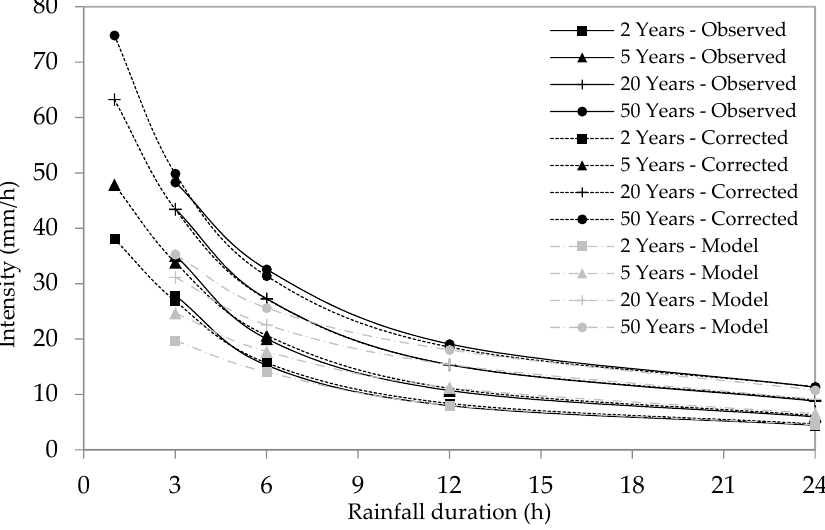
Figure 6. Observed, modelled and corrected present IDFs for 1981–2010.